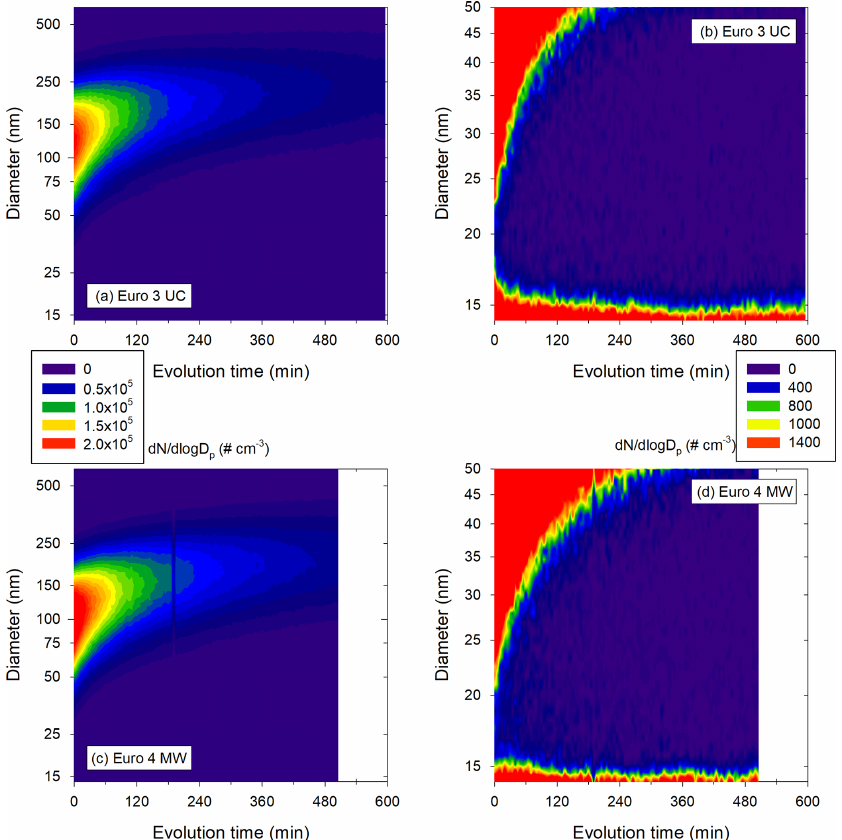
Figure H1. Measured PN distribution evolutions for the Euro 3 UC (a, b) and Euro 4 MW (c, d) conditions. The x axis gives the evolution time in minutes. The y axis gives the diameter in nanometers. The color scale gives the lognormal concentration. Panels (a) and (c) give the PN distributions for the whole SMPS measurement range. Panels (b) and (d) show the same cycles for the range 14 to 50nm. The color scales are changed to see the smallest